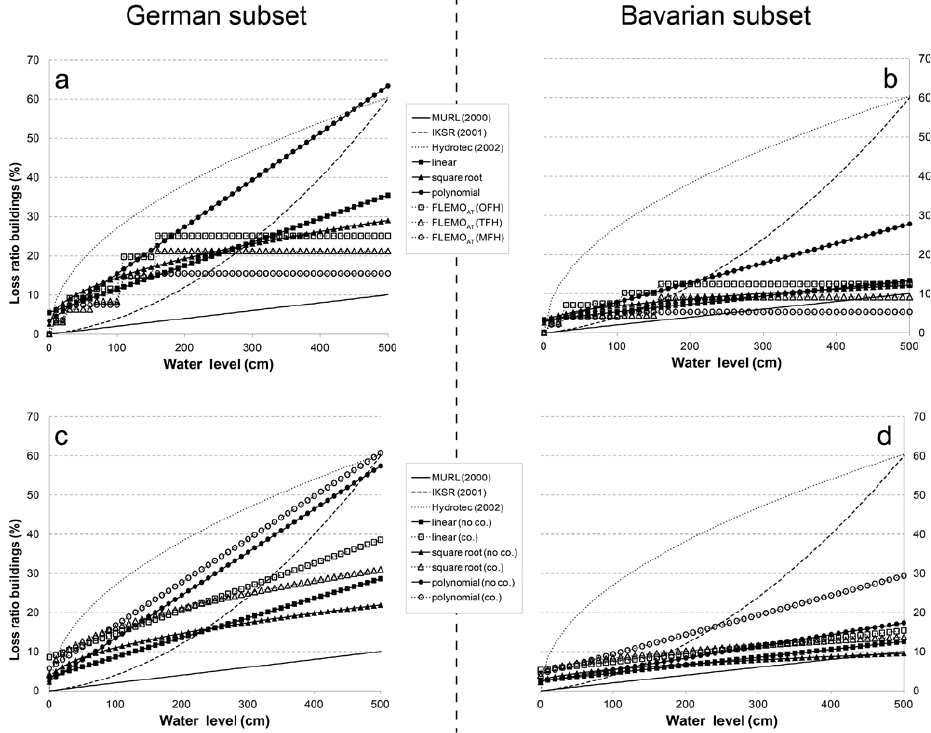
Fig. 4. Common stage-damage functions and newly derived ones from the mixed German subset left (a, c) and from the Bavarian subset right (b, d) . FLEMO AT curves in the upper figures are shown for one-family (OFH), two-family (TFH) and multi-family (MFH) houses. Functions differentiating between contamination (“co.”) and no contamination (“no co.”) are shown in the lower figures (c, d) of the corresponding